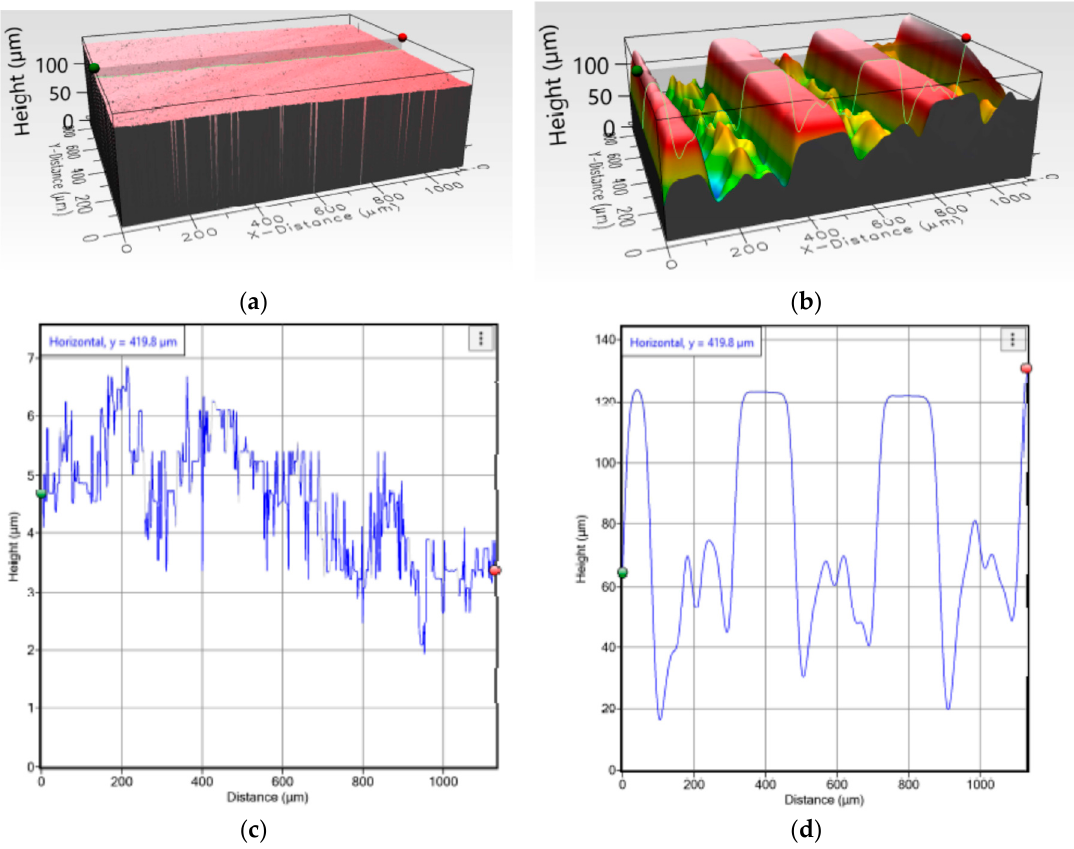
Figure 9. 3D topographical view of ( a ) smooth and ( b ) grooved TT samples. Roughness profiles along an arbitrary line on a ( c ) smooth and ( d ) grooved samples were determined from Figure 9a,b, respectively.